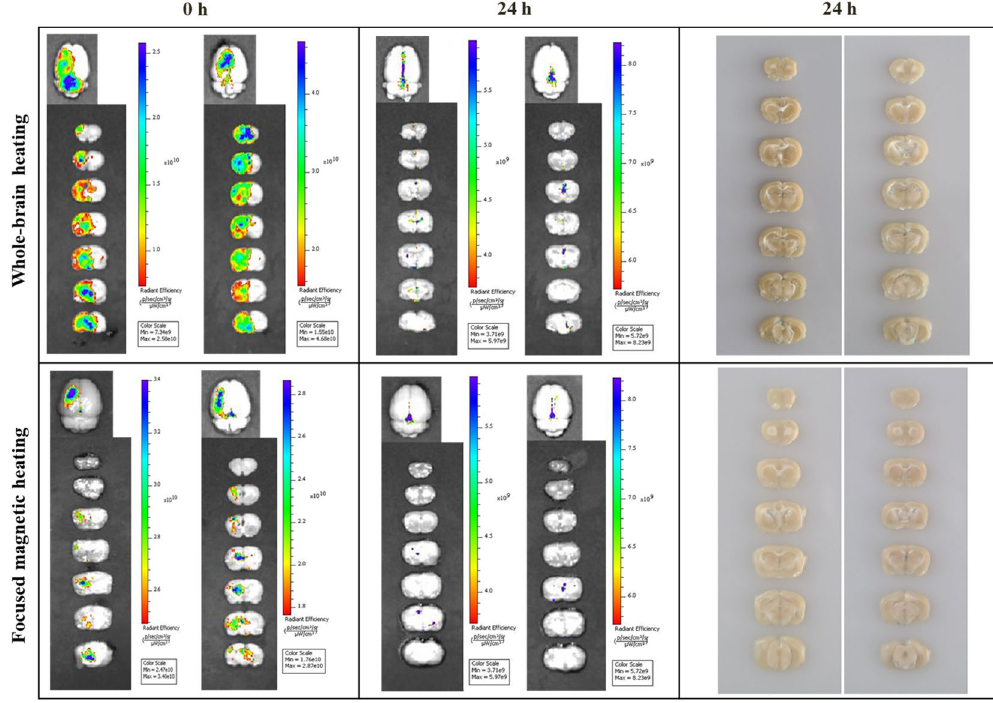
Figure 2. Evans blue fluorescence. Each row shows the recovery of BBB permeability after whole-brain (n = 10) and focused heating (n = 10) in a normal rat. Each column shows BBB recovery immediately after focused heating and after 24 h, as well as a brain-slice image after 24 h. The IVIS image showed that the permeability does not change with a magnetic field alone in the right cerebral hemisphere where the particles are not spread. Only by the MNP to which the magnetic field was applied could affect the area, even in the left hemisphere region where the particles are spread, the BBB permeability change occurred only in that region where a focused magnetic field was applied.